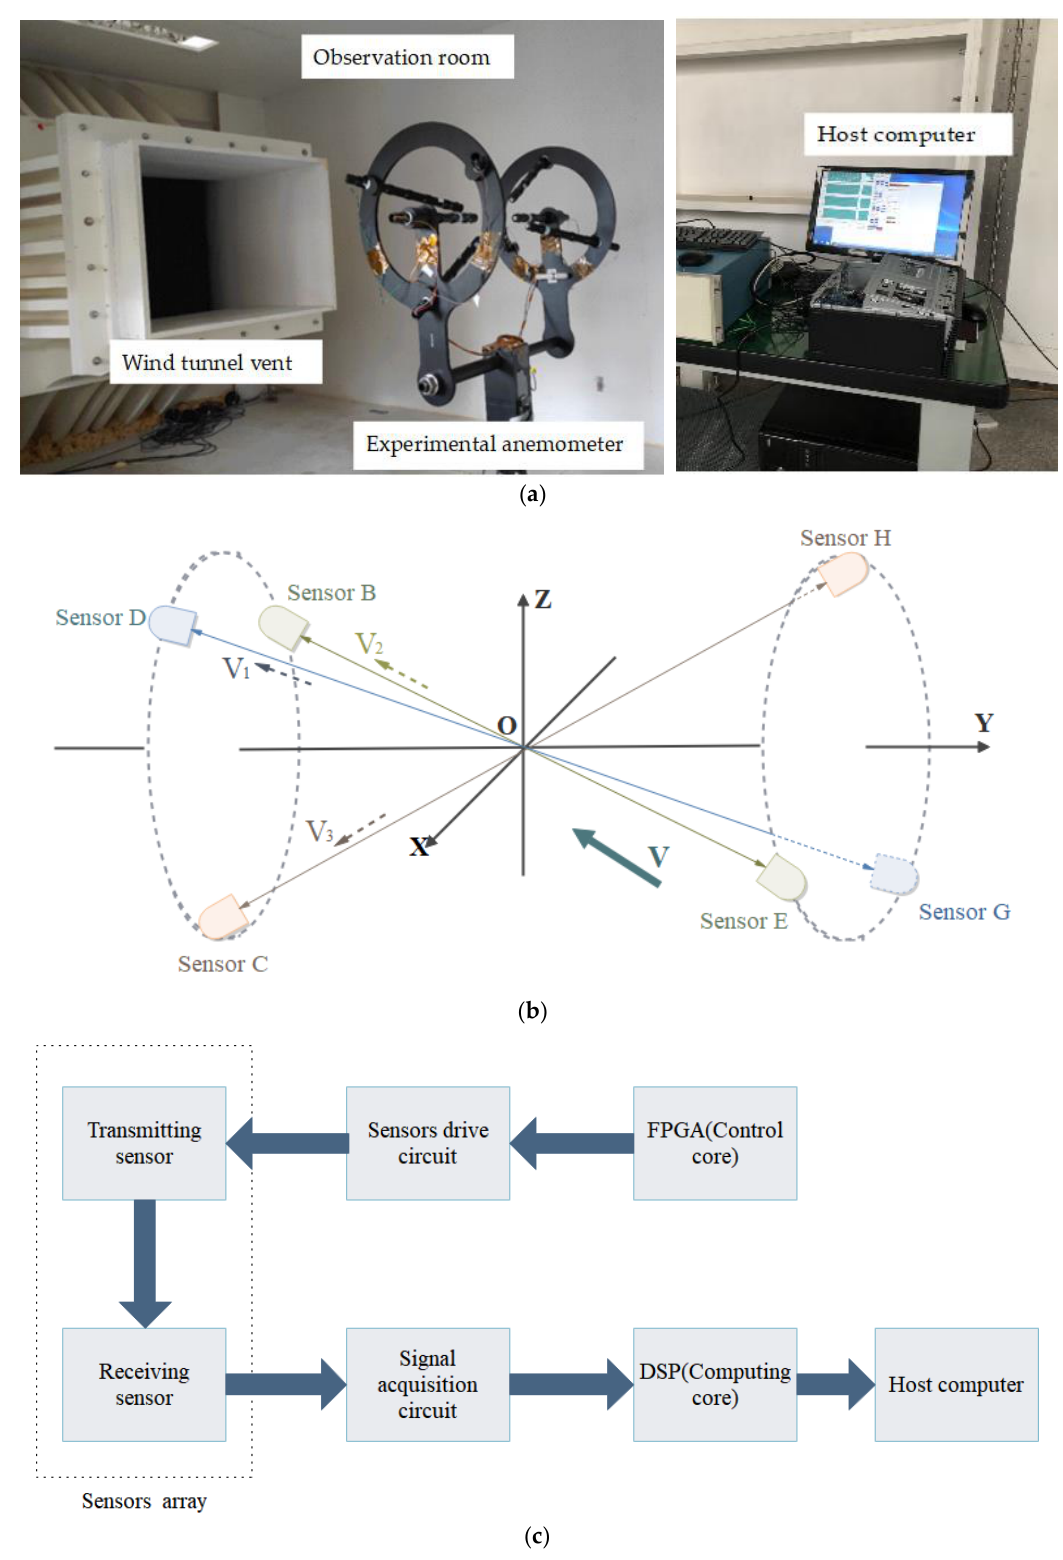
Figure 6. Hardware comprising experimental platform: ( a ) anemometer in wind tunnel; ( b ) sensor positions; ( c ) overall structure of experimental anemometer.